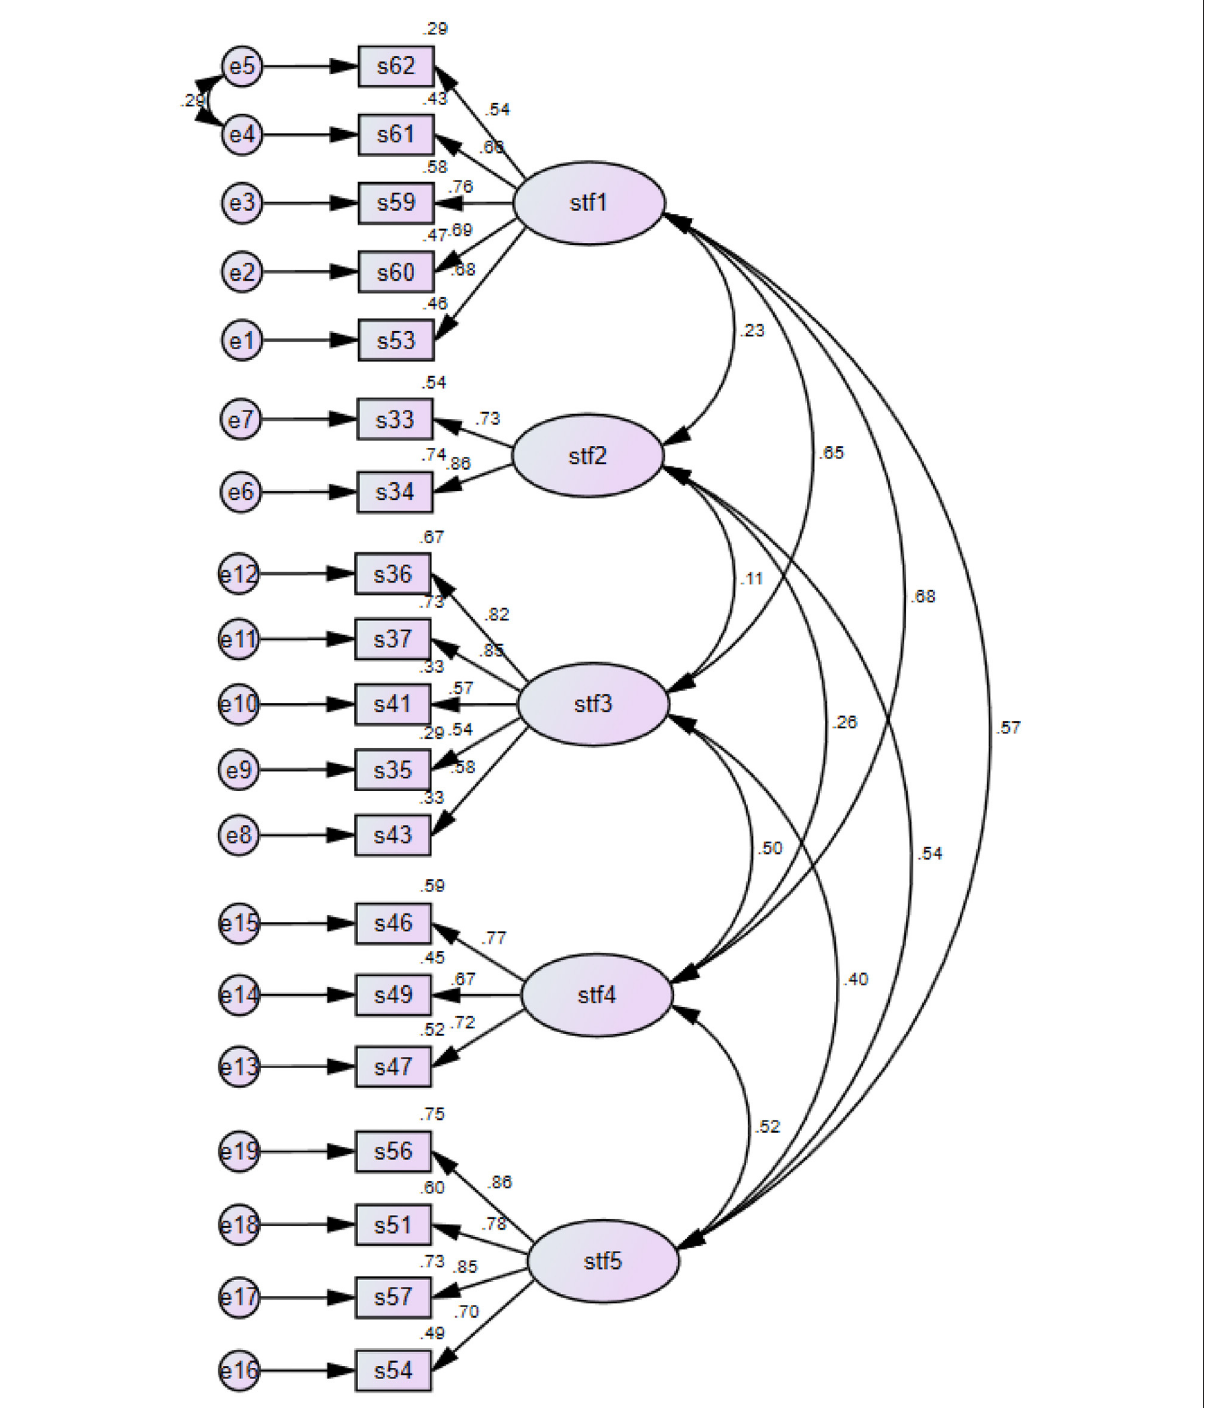
FIGURE2 Confirmatory factor analysis factor distribution path diagram.